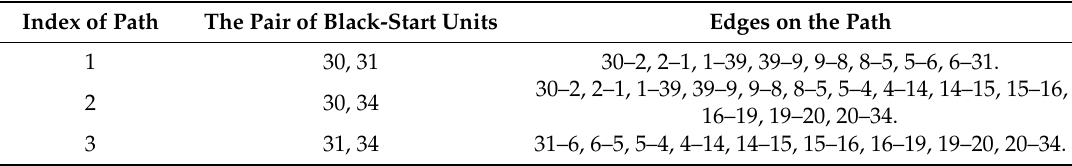
Table 1. The transmission paths connecting all black-start generating